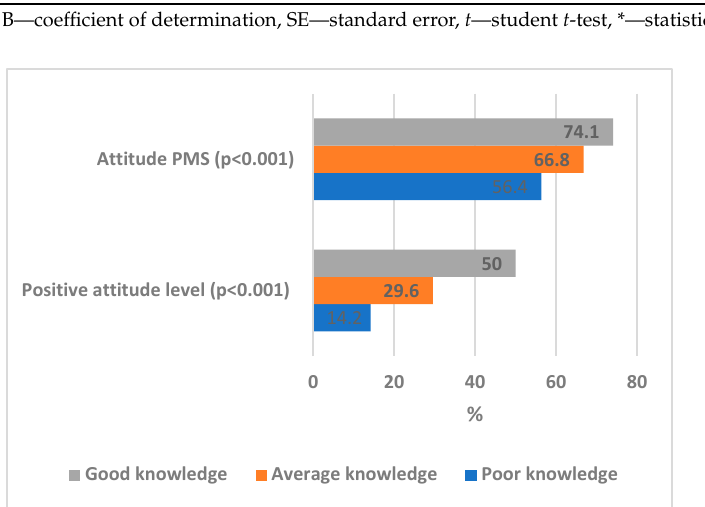
Figure 1. Association between the level of knowledge and attitude on OSA and the role of dentists.